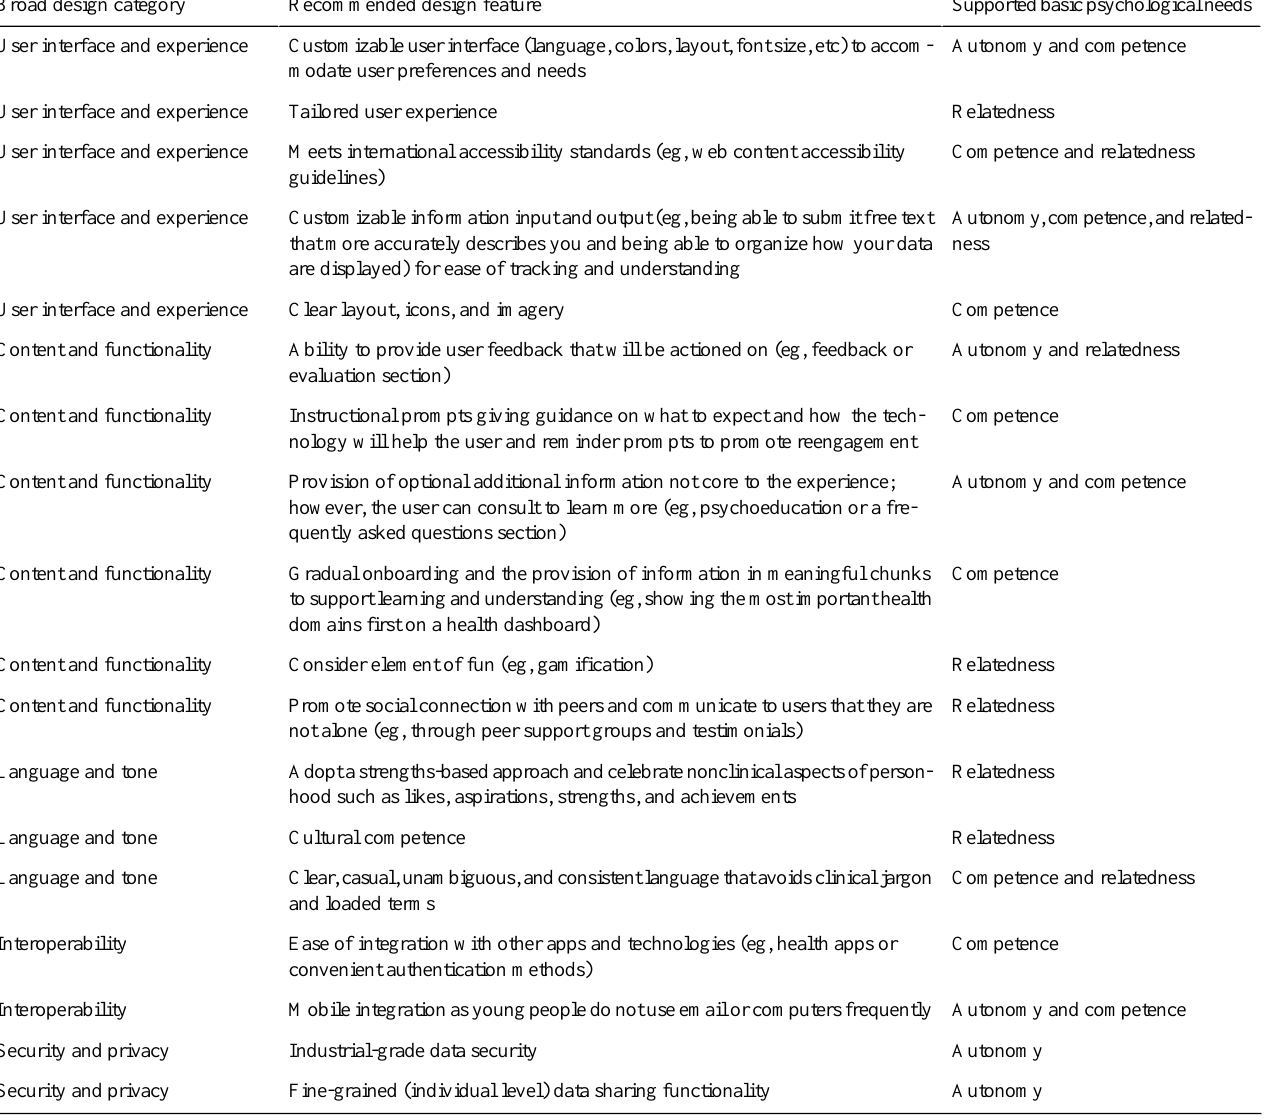
Table 3. Participants’recommended design features and corresponding basic psychological needs. needsUser interface and experience